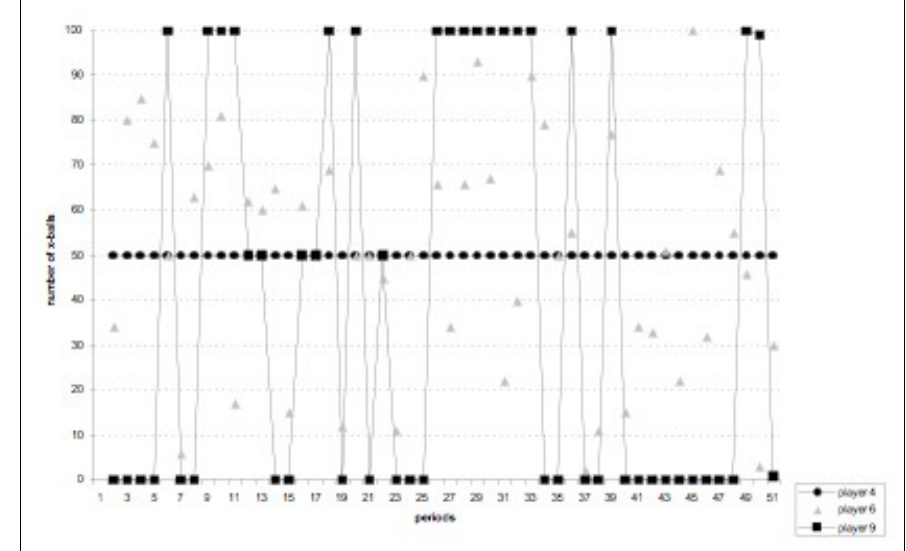
Figure 2. Temporal paths of X -balls